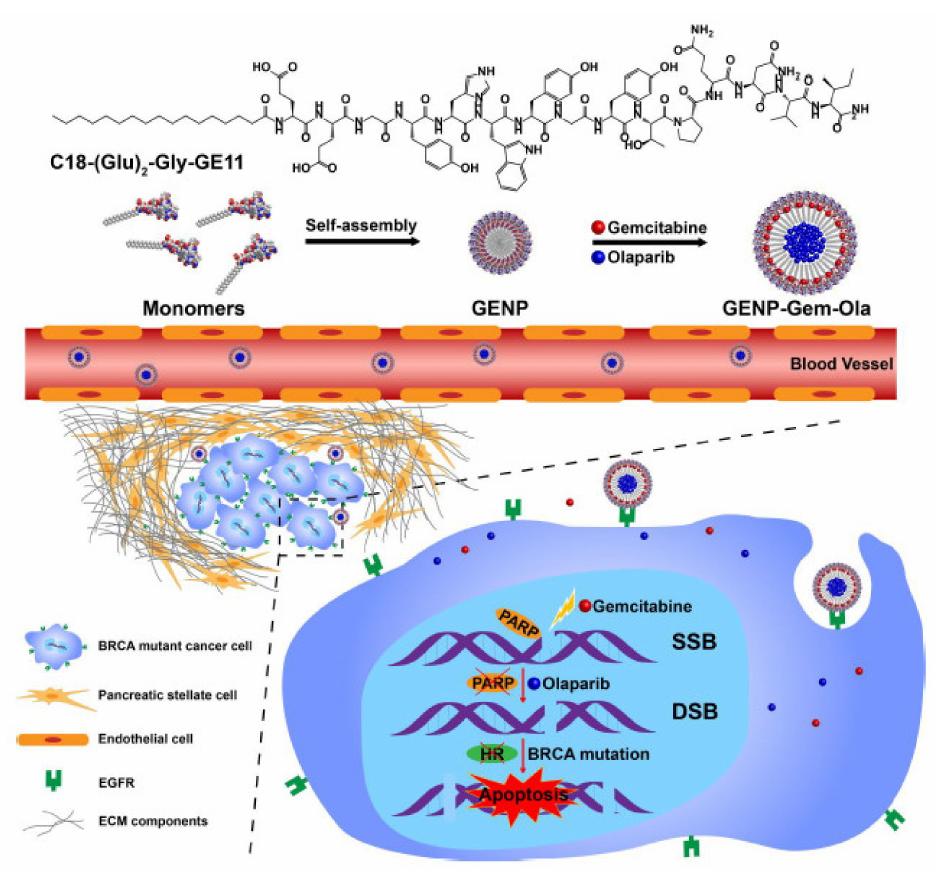
Figure 1. Self-assembly peptide nanoparticles (GENPs) that target EGFR and distribute gemcitabine and olaparib to pancreatic cancer cells. The mechanism that leads to cell apoptosis is represented by the inhibition of PARP through olaparib and DSBs generated by gemcitabine. Abbreviations: EGFR, epidermal growth factor receptor; ECM, extracellular matrix; PARP, poly ADP-ribose polymerase; DSBs, double-strand breaks. Reprinted with permission from